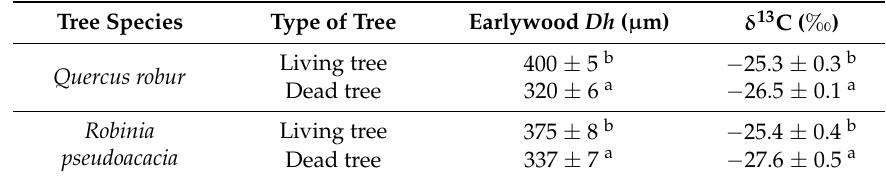
Table 3. Earlywood hydraulic diameters ( Dh ) and values of tree-ring carbon isotope discrimination ( δ 13 C) obtained for living ( n = 5) and recently dead ( n = 5) trees in both study species. Data correspond to the 2006–2015 period. Values are means ± SE. Different letters indicate significant ( p < 0.05) differences between the two tree types based on t